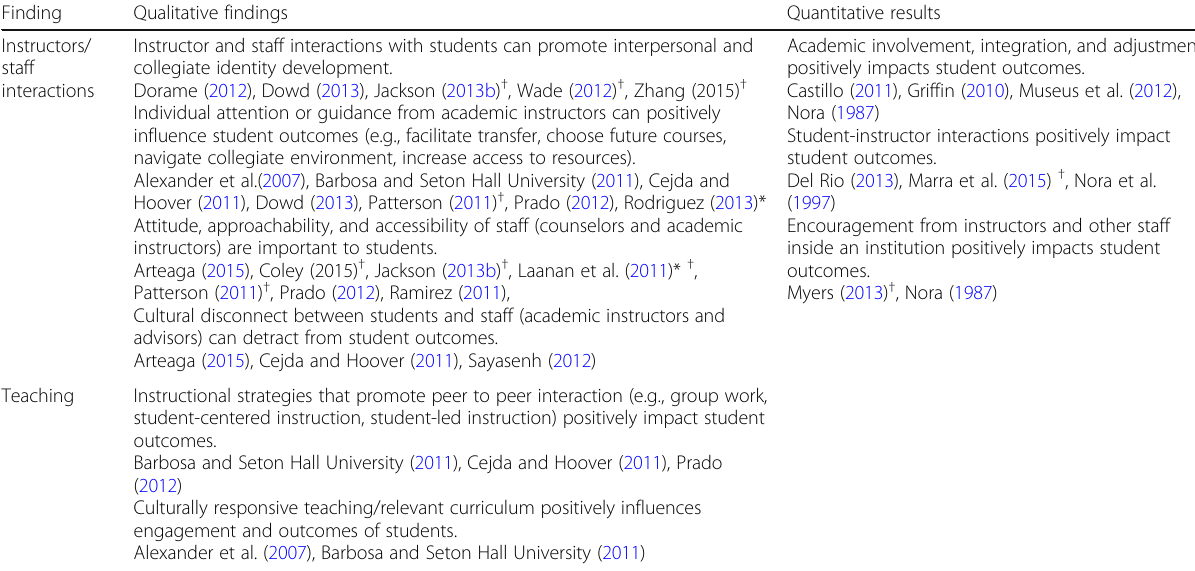
Table 4 Findings with higher education instructors and other staff as the locus of control